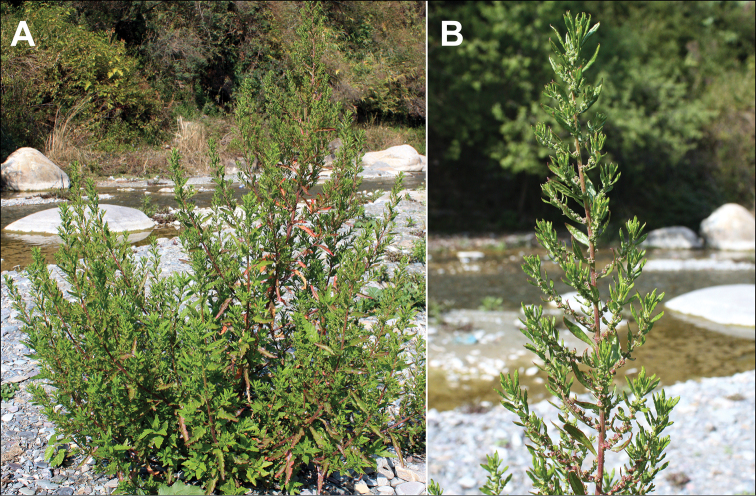
Dysphaniaambrosioides: A general view B close-up of the inflorescence branch. Photographs by A. Sukhorukov (Dehradun, Uttarakhand, India, February 2018).